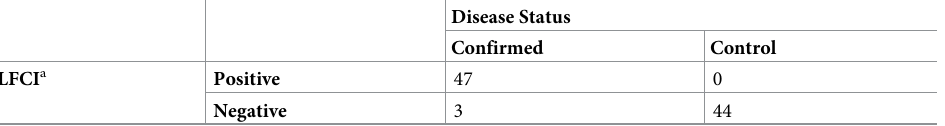
Table 2. Cross-tabulation of SARS-CoV-2 infection status and a commercial lateral flow chromatographic immu- noassay (LFCI) test